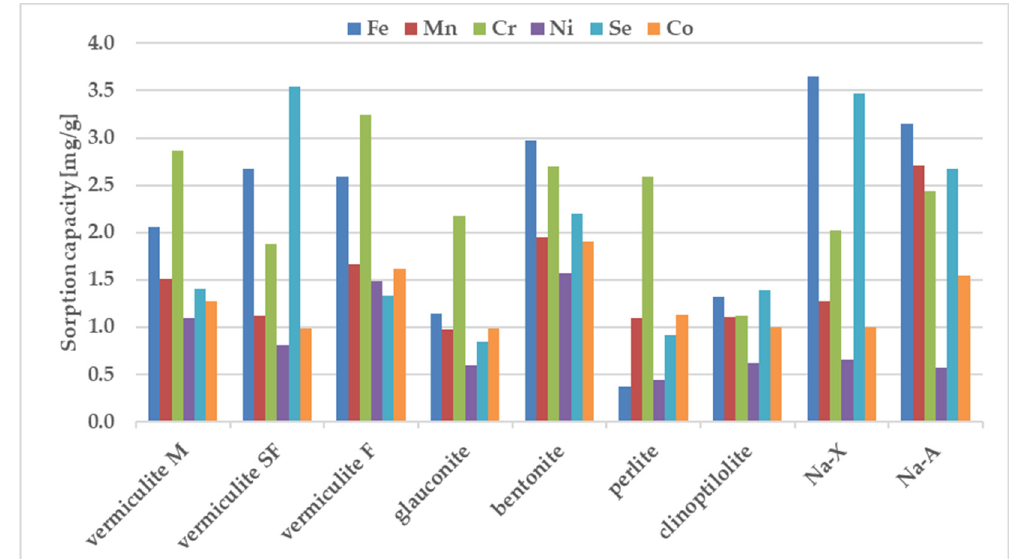
Figure 3. The sorption capacity of the investigated sorbents towards mixture of ions, estimated in batch study. Initial ion concentration c 0 = 100 mg L − 1 , volume of solution = 12 mL, mass of sorbent = 0.3 g, contact time = 1 h. The measurements were conducted at the room temperature (23 ± 0.2 °C).